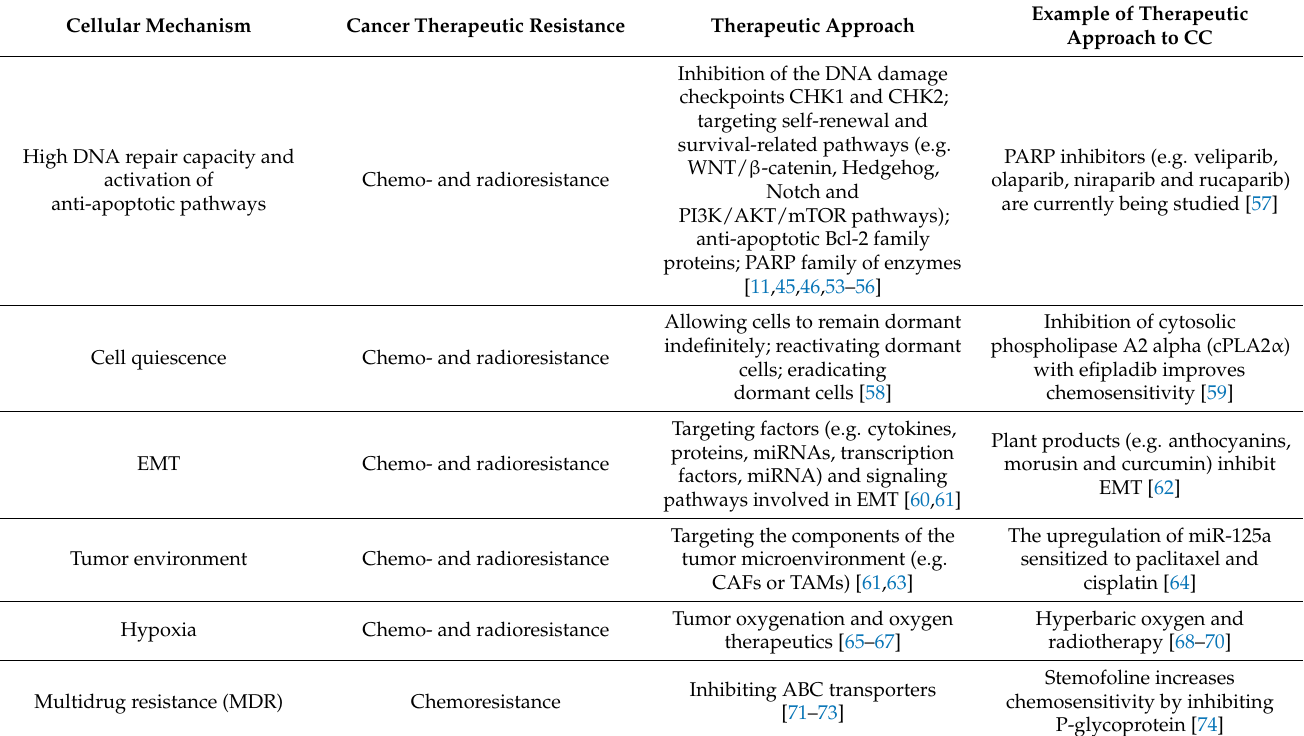
Table 2. Main cellular mechanisms of resistance of CSCs to therapies and potential therapeutic